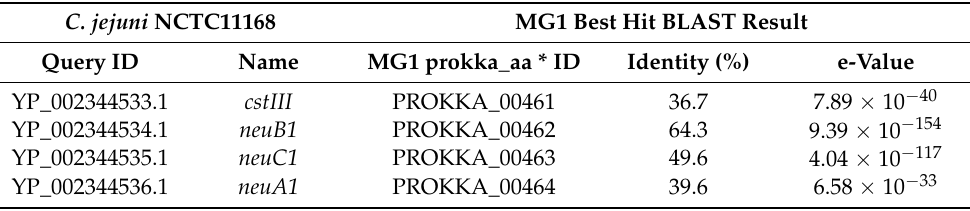
Table 3. Presumptive MG1 group 1 lipooligosaccharide loci identified by BLAST analysis of